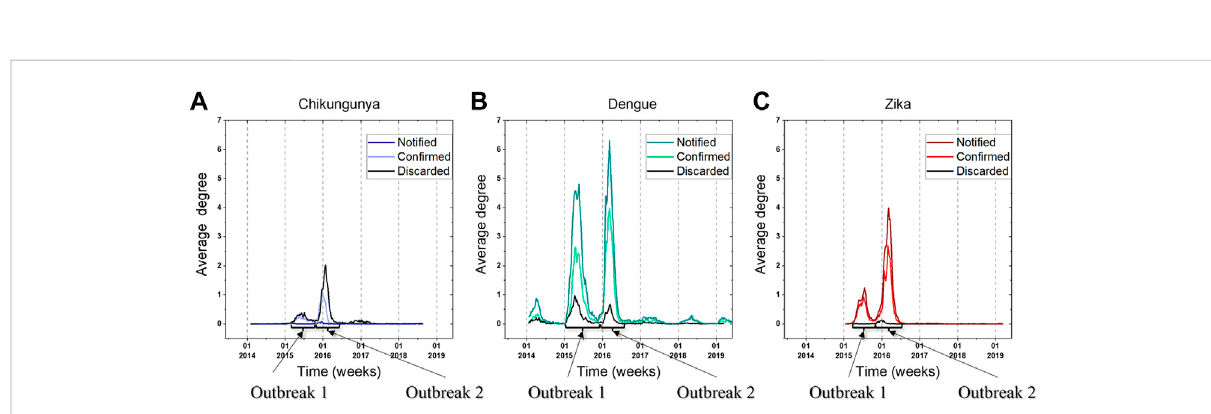
FIGURE 5 TimeevolutionoftheaveragedegreeofTVGtonetworksofnoti fi ed,con fi rmedanddiscardedcases. (A) Chikungunya. (B) Dengue. (C) Zika.The vertical grid lines highlight the beginning of a new year.